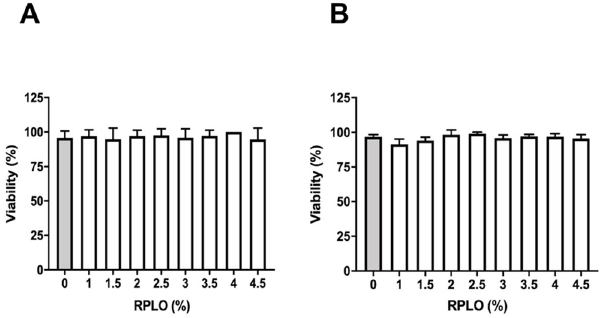
Fig 5. Acute toxicity of RPLO in the C. elegans experimental model in vivo. Viability was recorded at (A) 24 h and (B) 48 h of treatment. The graph shows the means ± SEM of three independent experiments performed in triplicate (n = 90). The observed changes were not statistically significant